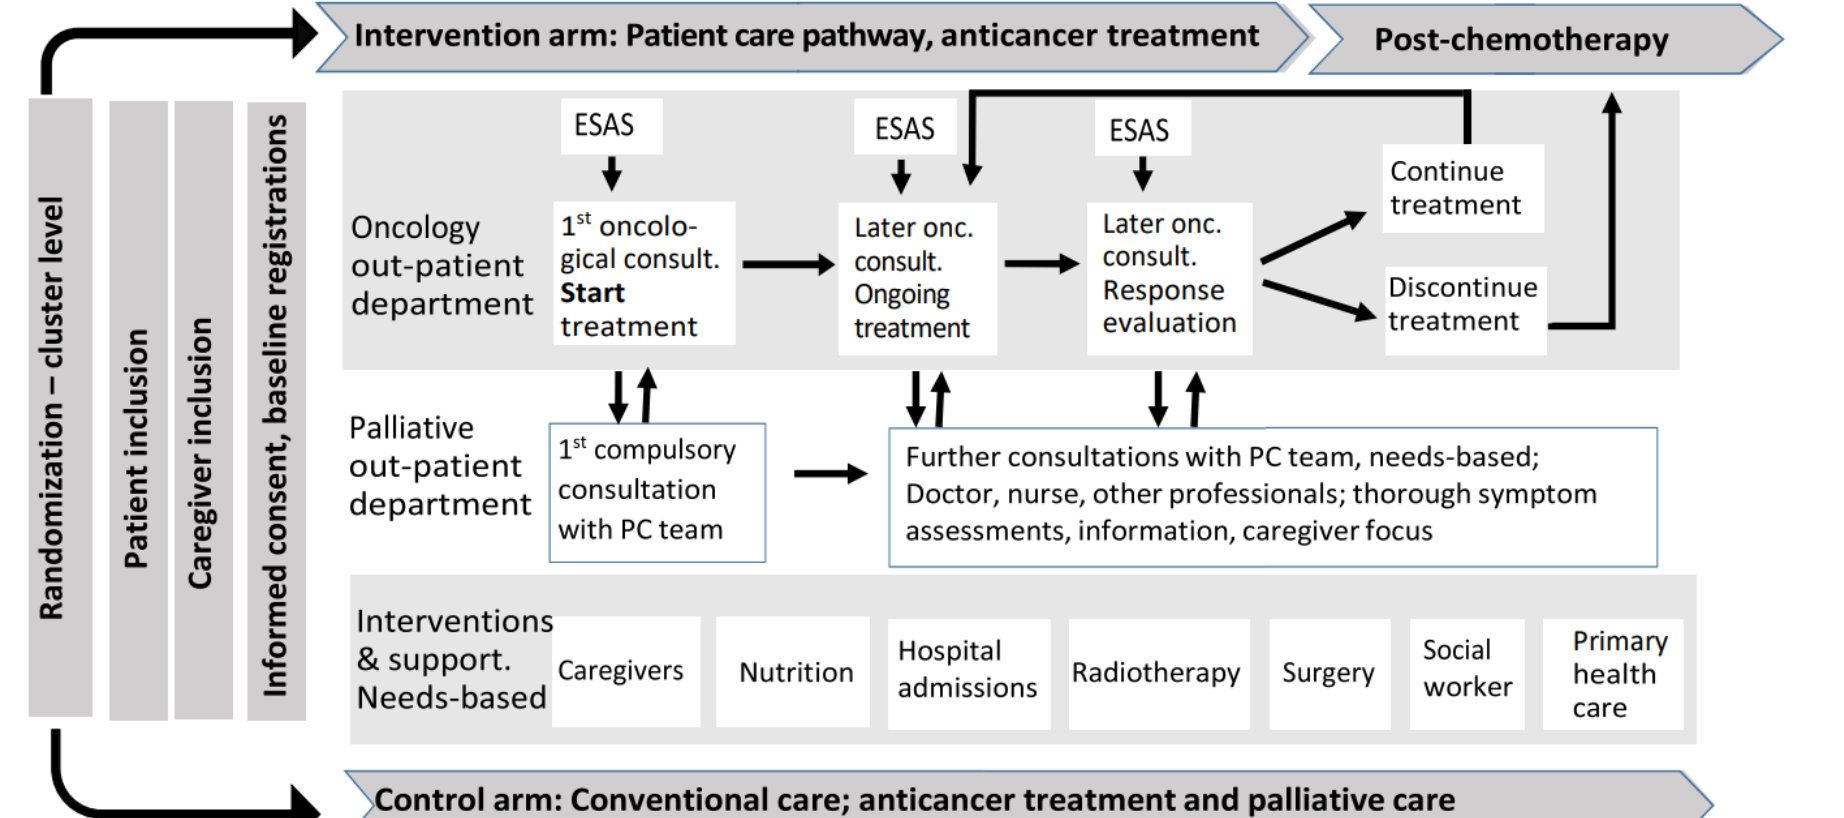
Figure 1. Overview of the PALLiON patient pathway. ESAS; Edmonton Symptom Assessment System [37].